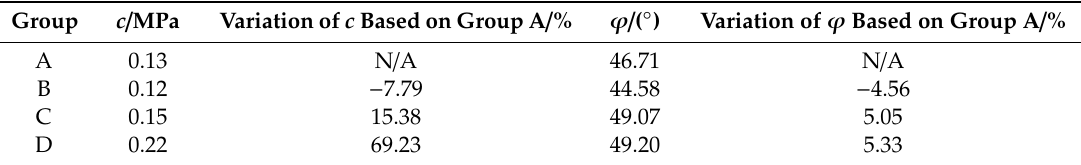
Table 6. Cohesion and internal friction angle of briquettes with different particle sizes.